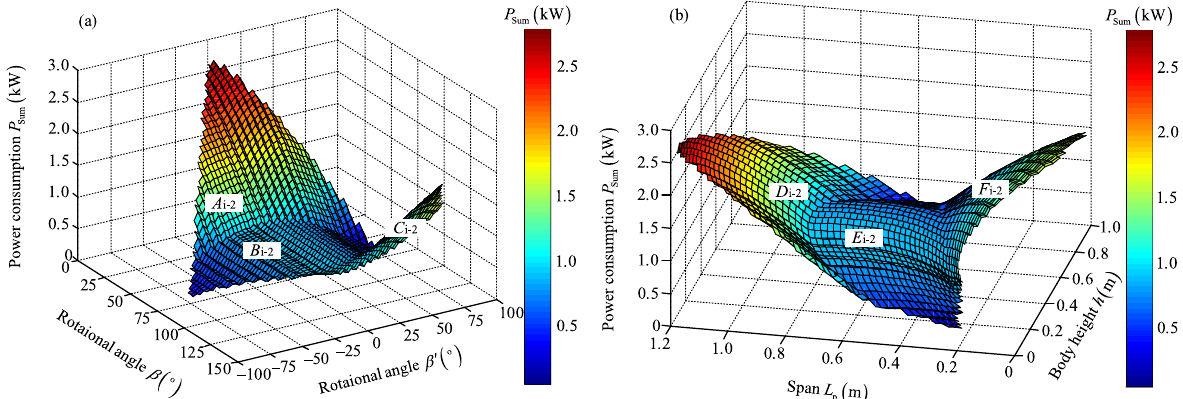
Figure 9 Variable tendency charts of P sum under secondary working conditions i-2: (a) With changes in β ′ and β , (b) with changes in h and L p